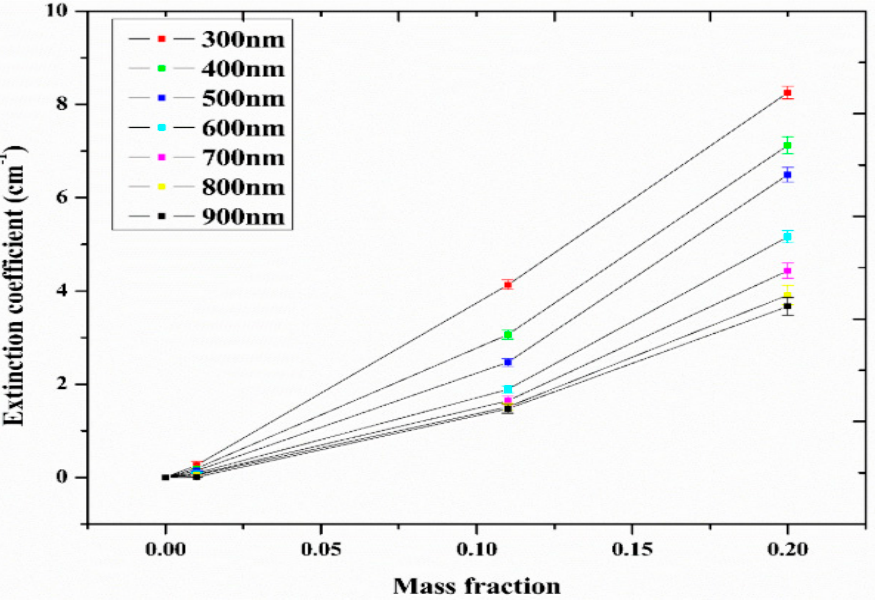
Figure 6. Extinction coefficient of ATO-Ag/DIW nanofluid as a function of mass fraction under varying wavelengths (Adapted from Sreekumar et al. [63]).